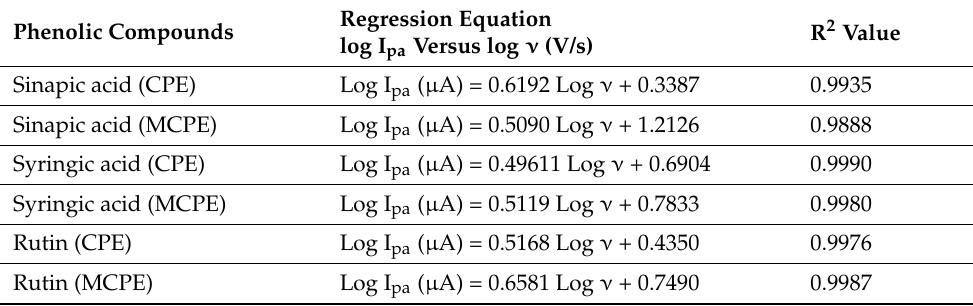
Table 3. Linear regression equation showing the logarithm of anodic peak current and logarithm of scan rate (log Ip versus log ν (V/s) for the phenolic compounds at CPE and MCPE with their slopes and R-square values. Phenolic Compounds